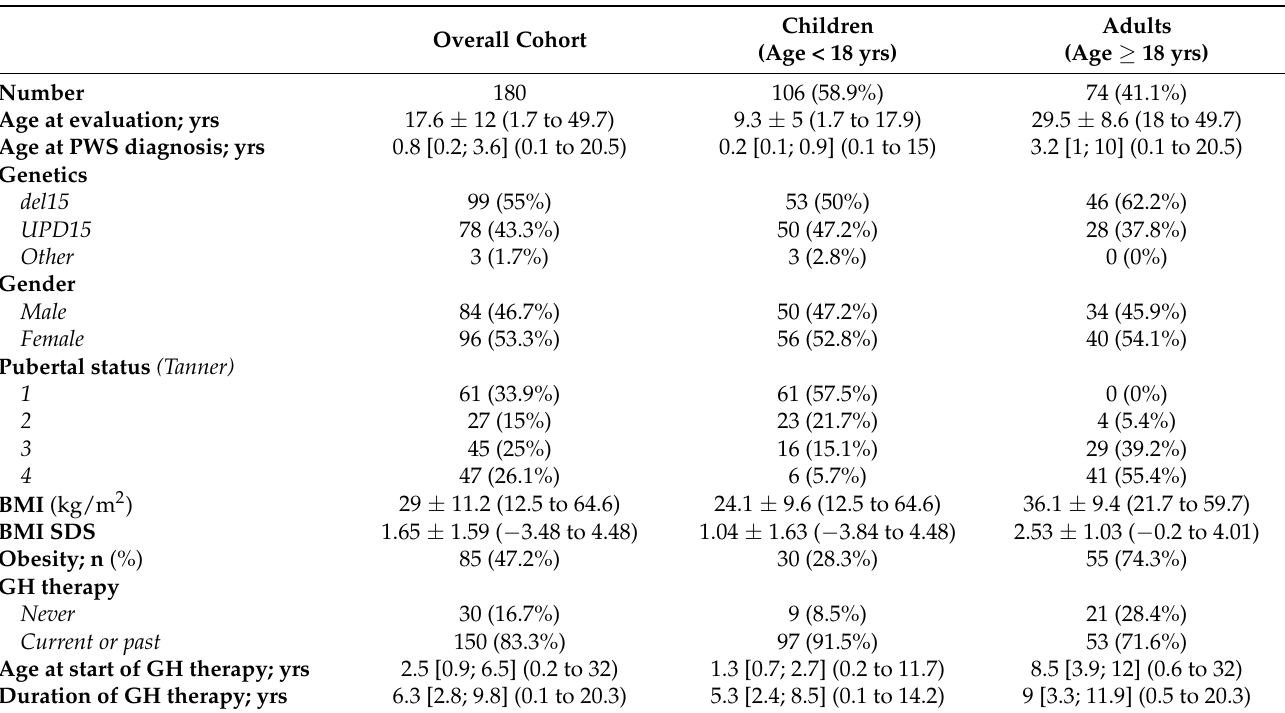
Table 1. Demographical, genetic and clinical characteristics of the entire population of the study stratified by age. Overall Cohort